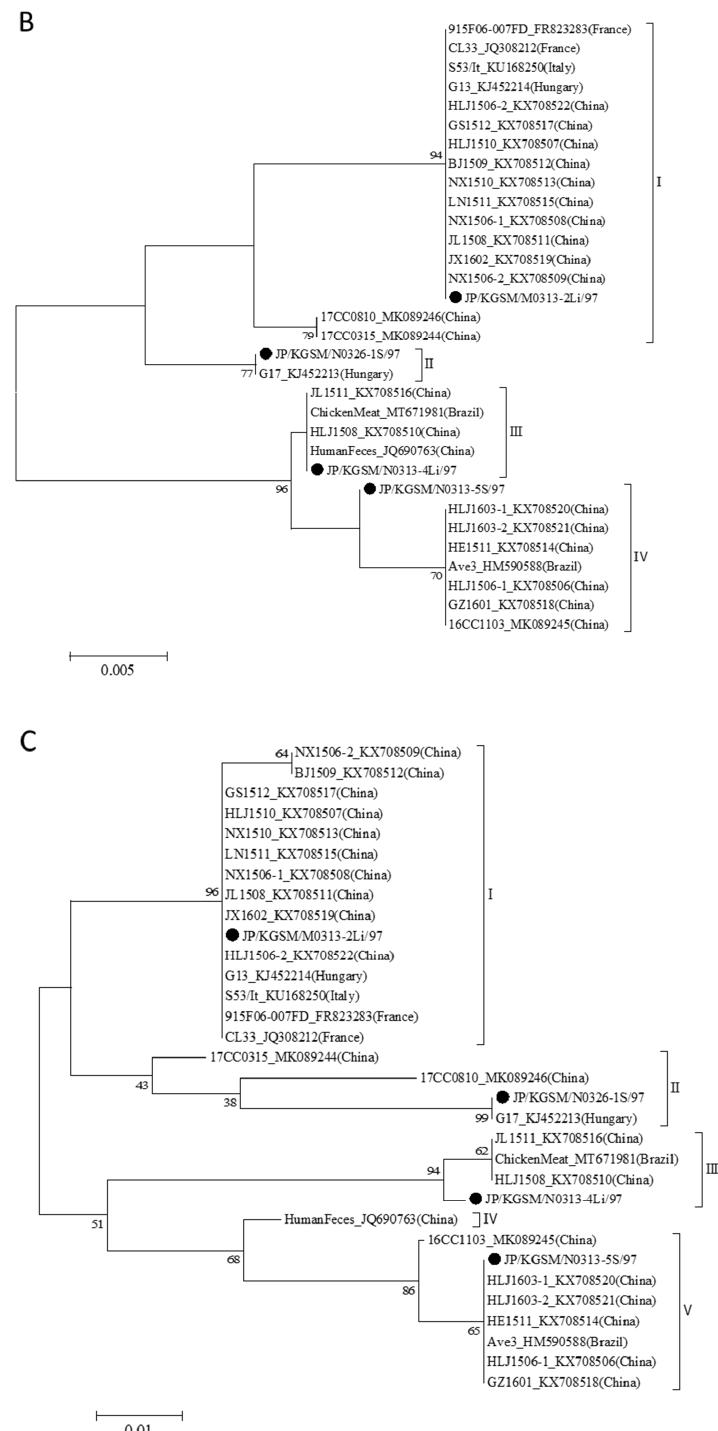
Figure 4. Phylogenetic analysis of the amino acid sequences of VP1 ( A ), VP2 ( B ), and VP3 ( C ) of GyVg1. The predicted amino acid of complete sequences of each protein was subjected to phylogenetic analysis. Subsequently, a tree was generated using the neighbor-joining method in MEGA 7 with 1000 bootstrap replicates. All tools were run with default parameters unless otherwise specified. Then, horizontal distances were proportionally set to the minimum number of nucleotide differences required to join nodes and sequences. The Japanese GyVg1 strains are indicated by black circles. The genotypes were defined as described by Yao et al.